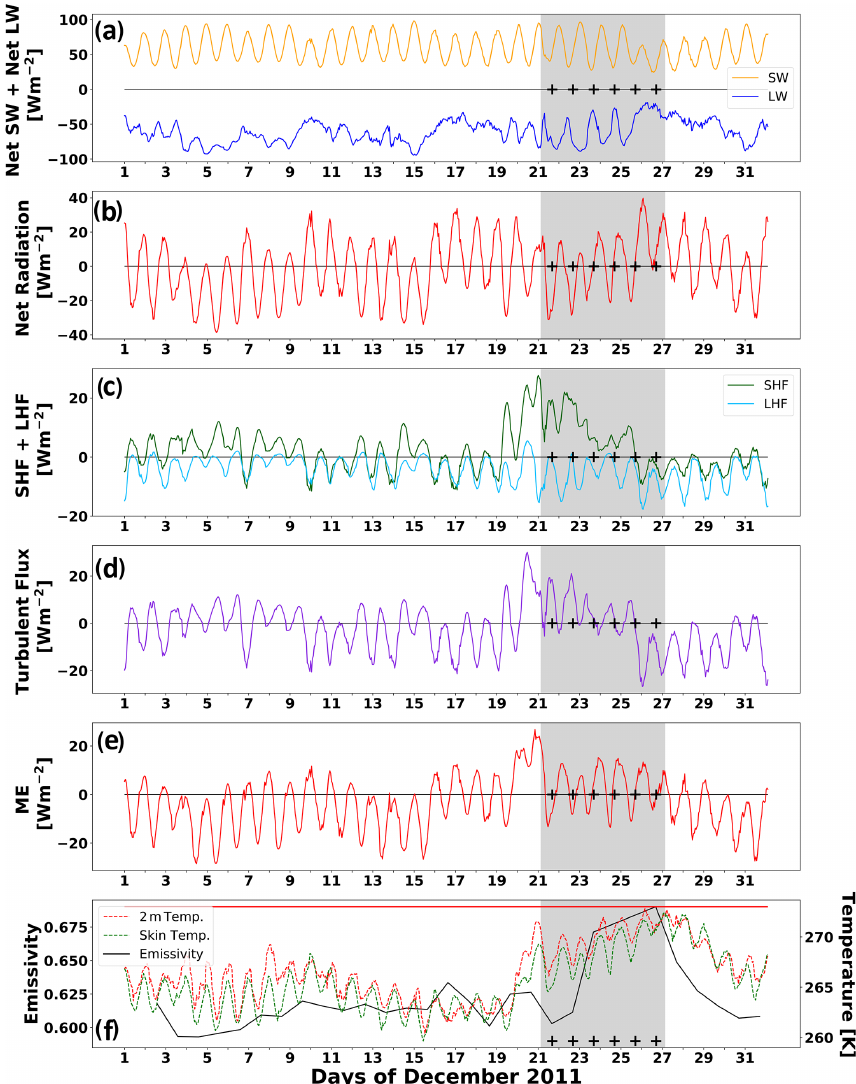
Figure 19. As in Fig. 4 but over the Siple Dome region throughout December